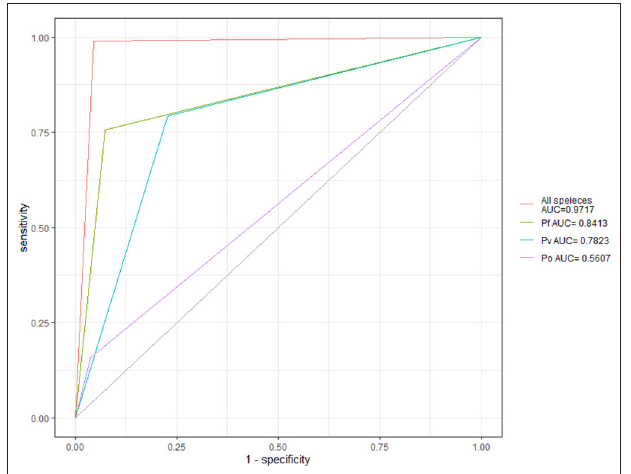
FIGURE 2 | The technicians’ microscopy ROC curve for different plasmodium species.